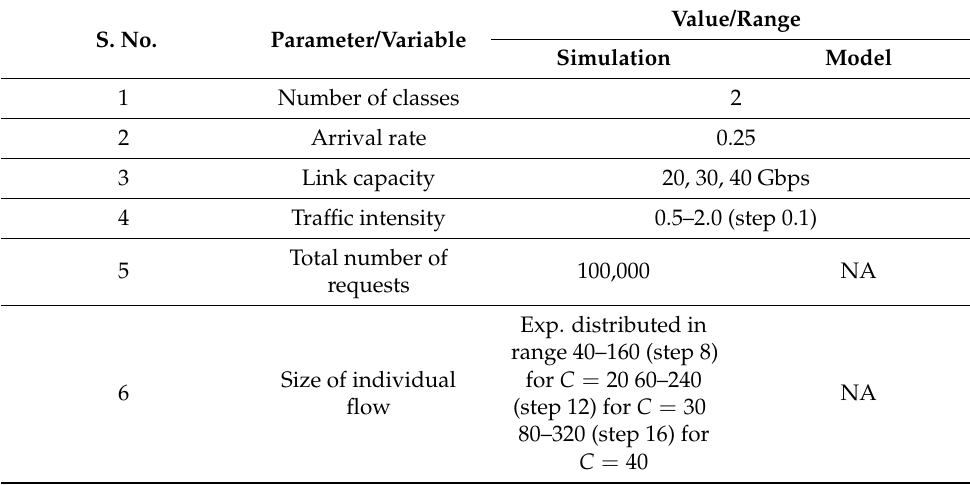
Table 1. Configuration setup for simulation and model. S.